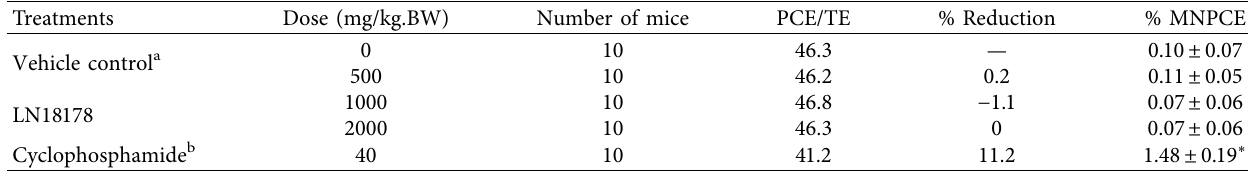
Table 11: Micronucleated polychromatic erythrocytes (MNPCEs) in LN18178-treated mice bone marrow. Treatments